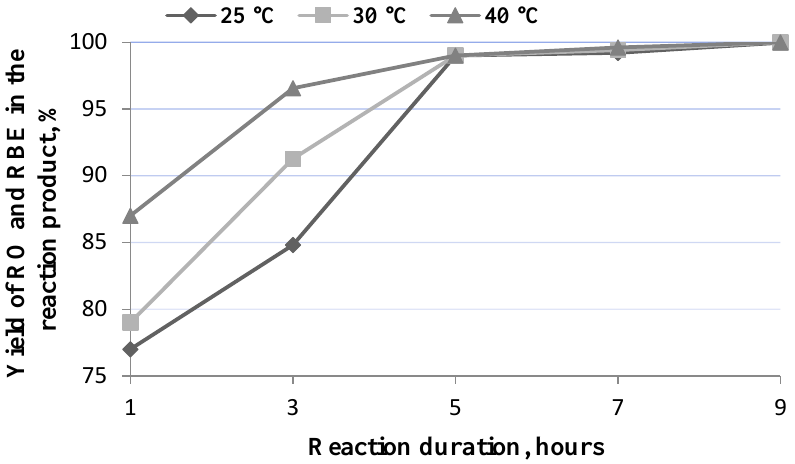
Figure 2. Dependence of RO and RBE yield on reaction time and temperature.